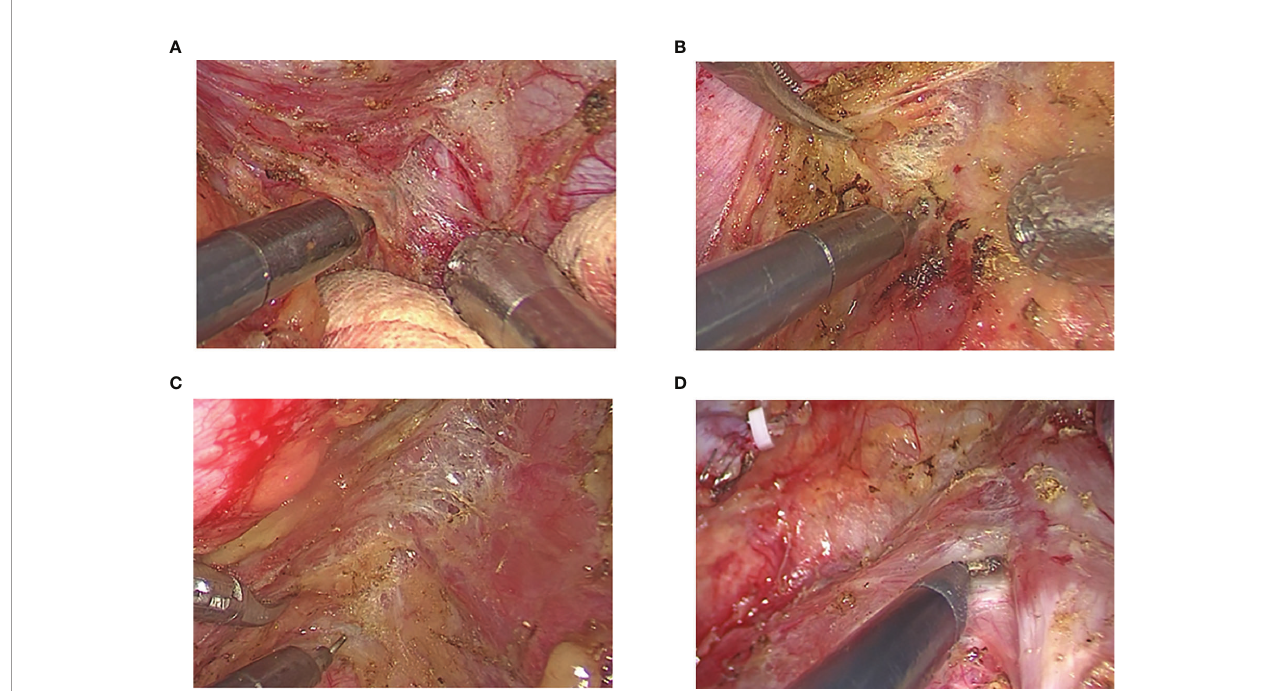
FIGURE 4 | (A) Fibrosis in esophageal mesentery near primary tumor. (B) Fibrosis in esophageal mesentery near pericardium. (C) Fibrosis in esophageal mesentery near thoracic aorta. (D) Fibrosis in esophageal mesentery near